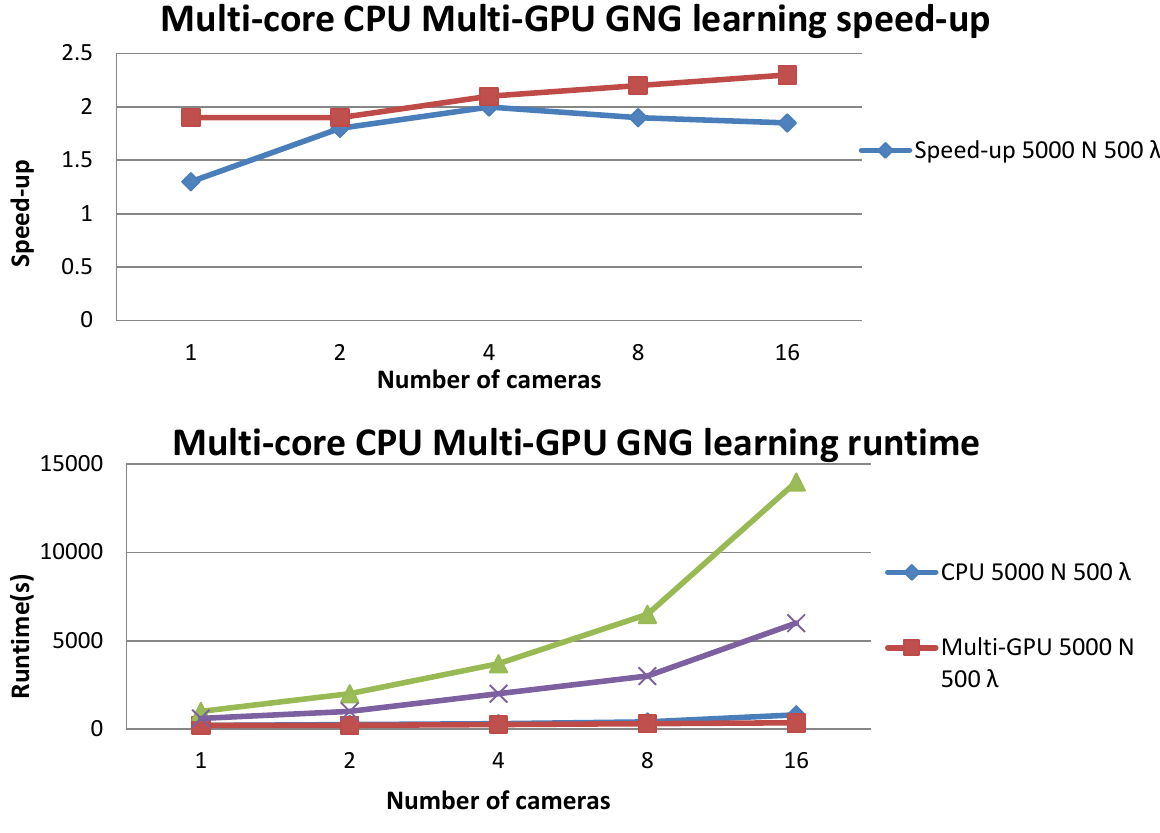
Figure 8. Execution times and speed-up for different GNG learning parameters and different numbers of cameras.